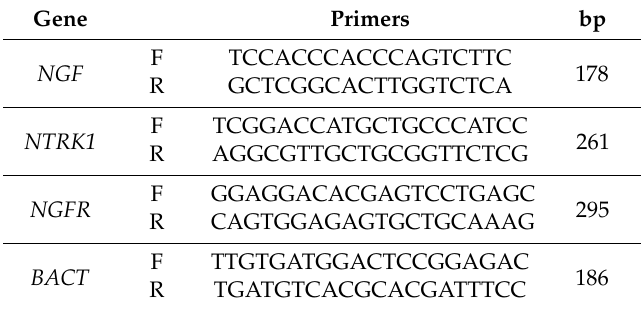
Table 1. Primers for NGF , NTRK1 , NGFR, and BACT (used as internal standard) for real-time PCR quantification. Gene Primers bp